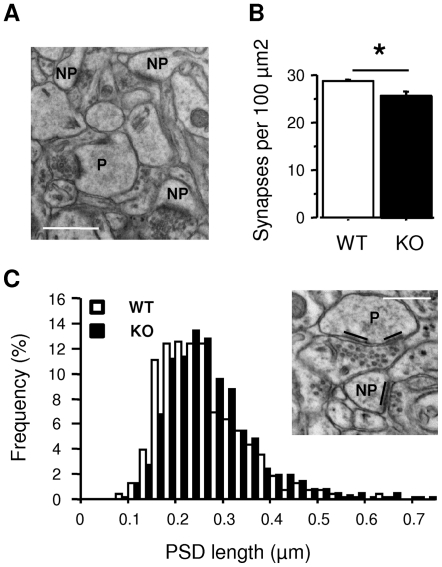
Dp71 loss affects density and morphology of axospinous asymmetric synapses in CA1 hippocampus in vivo.A. Electron micrograph showing the CA1 neuropil (stratum radiatum) with typical non-perforated (NP) and perforated (P) subtypes of excitatory synapses. Scale bar, 1 µm. B. Relative density of axospinous asymmetric synapses expressed as synapses per 100 µm2. *p<0.05. C. Frequency histogram distributions of the PSD length of sampled CA1 spine synapses in 25 nm bins. Insert shows measures of PSD length in NP and P synapses, with the total length of a perforated PSD estimated as the sum of the individual electron-dense traces. Scale bar: 0.5 µm.